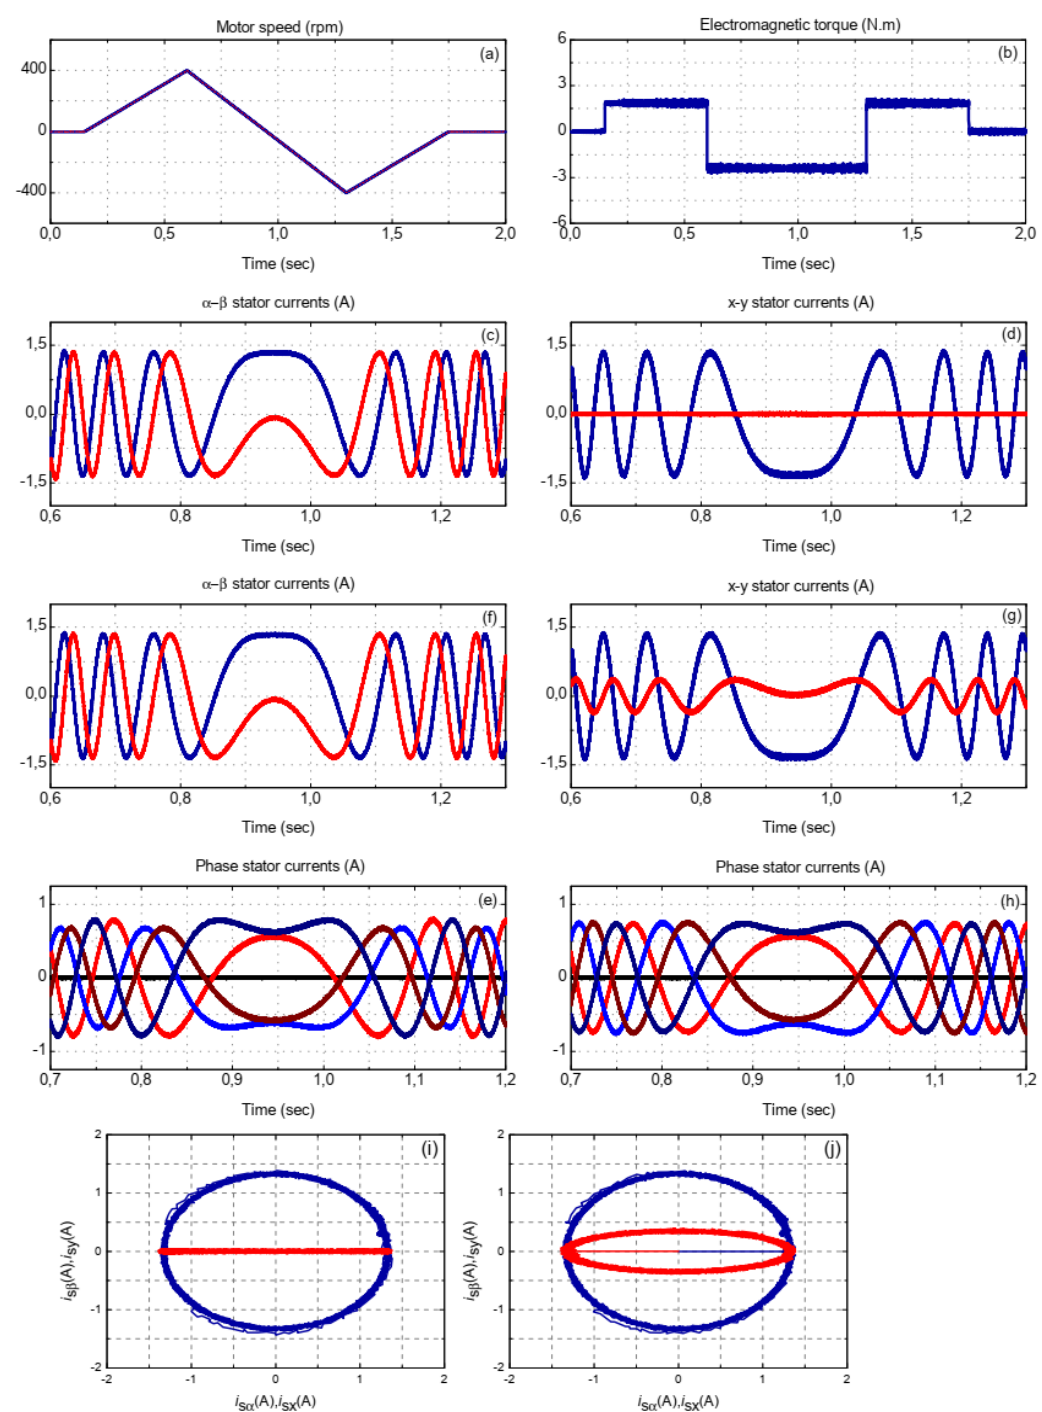
Figure 9. Simulation results of RFOC ( a ) motor speed, ( b ) Electromagnetic torque, ( c ) α–β stator currents ML, ( d ) x – y stator currents ML, ( e ) α–β stator currents MD, ( f ) α–β stator currents MD, ( g ) phase stator currents ML, ( h ) phase stator currents MD, ( i ) current trajectories in the α–β plane ML, ( j ) current trajectories in the x – y plane MD.